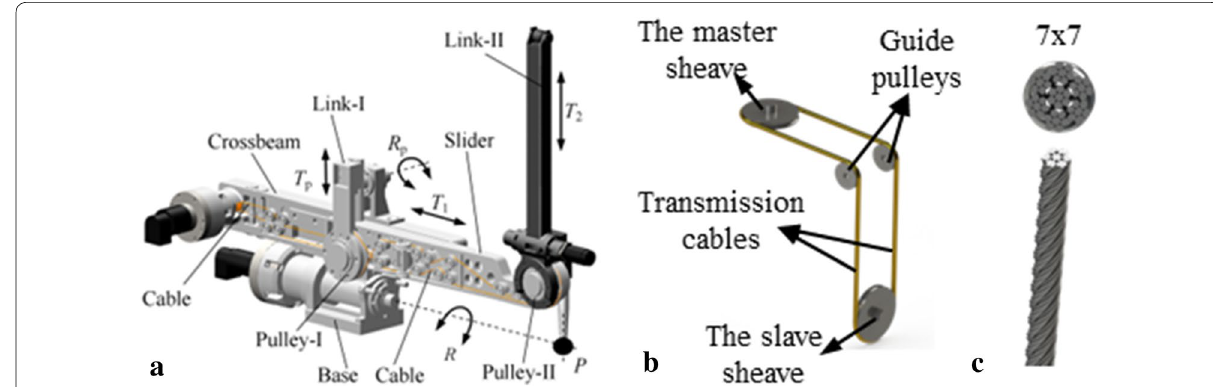
Figure 2 ( a ) Robotic arm driven by cables [8]; ( b ) Typical single-loop cable-driven transmission system; ( c ) Cable